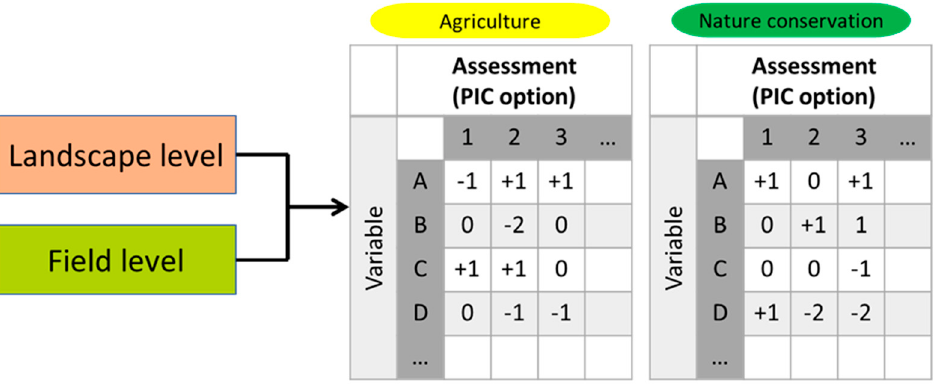
Figure 3. Schematic representation of the valuation of the PIC options in the assessment matrix.